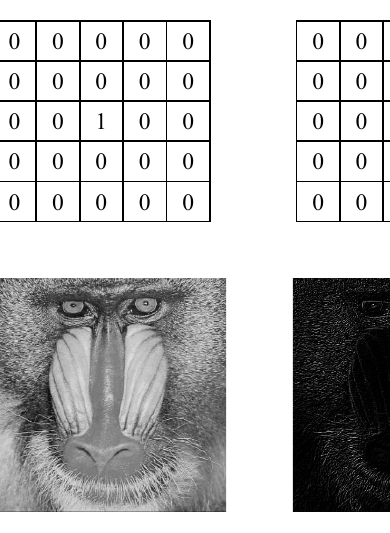
Figure 5. Neutral kernel and high ‐ pass kernels.